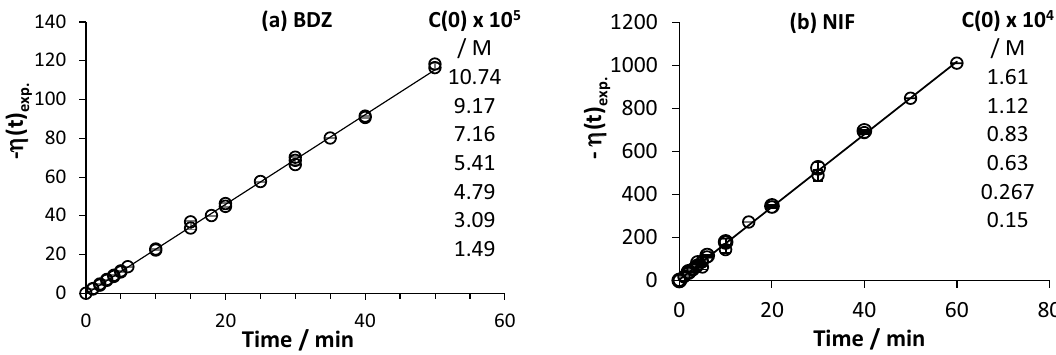
Figure 5. Linear η-order correlations (according to Eq. 9) for the experimental photokinetic traces of ( a ) DBZ and ( b ) NIF, measured at various initial concentrations and exposed to Lamp #4. The error bars indicate an RSD less than